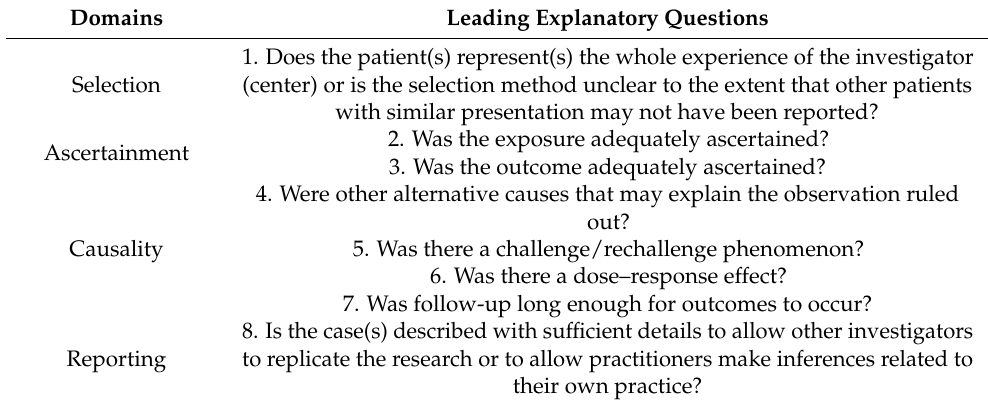
Table 2. Tool for evaluating the methodological quality of case reports and case